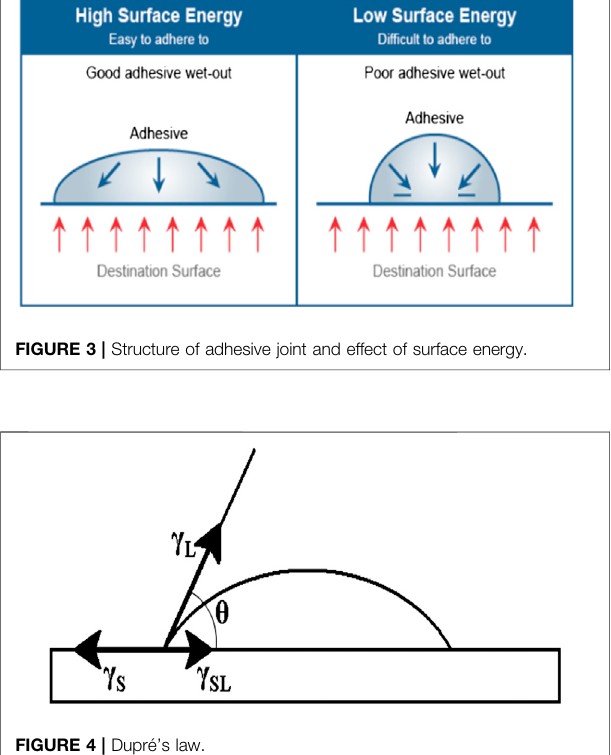
FIGURE 4 | Dupré ’ s law.